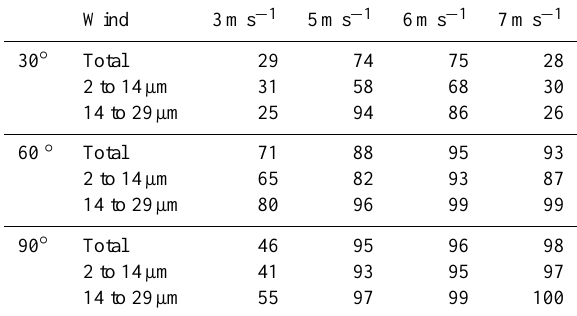
Table 4. FSSP concentration loss in percentage compared to the isoaxial measurement concentration, as a function of the wind speed and the angle between wind direction and instrument orientation. For each angle and wind speed value, this percentage is computed for the entire size range (2 to 45µm), the small particles (2 to 14µm) and the large particles (14 to 29µm).